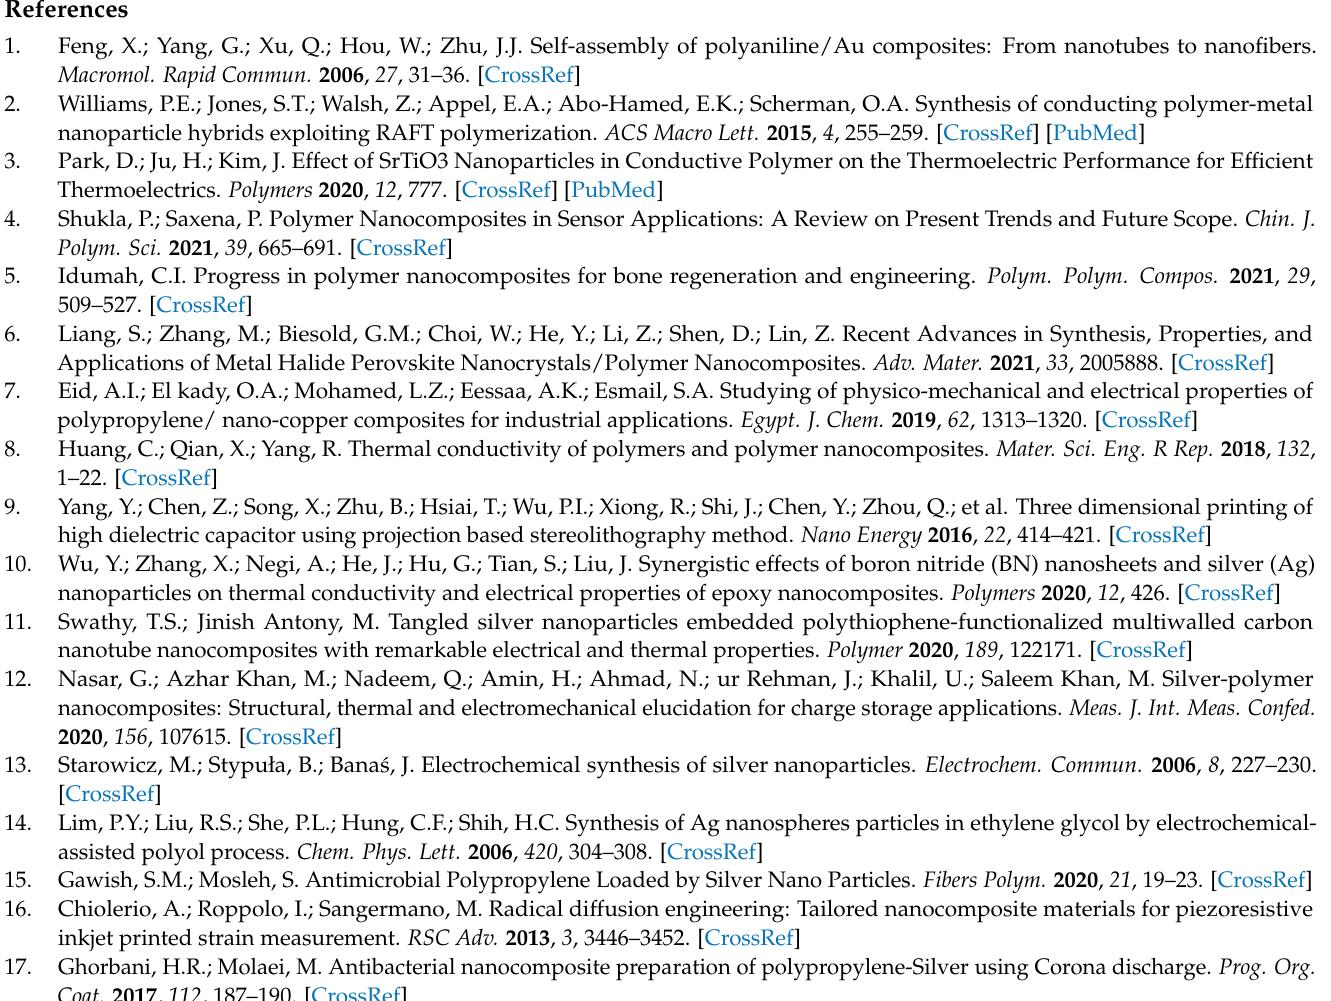
solvent present in the nanocomposites deducted from the TGA analysis. Table S2: Weight percentage of Ag in the printed